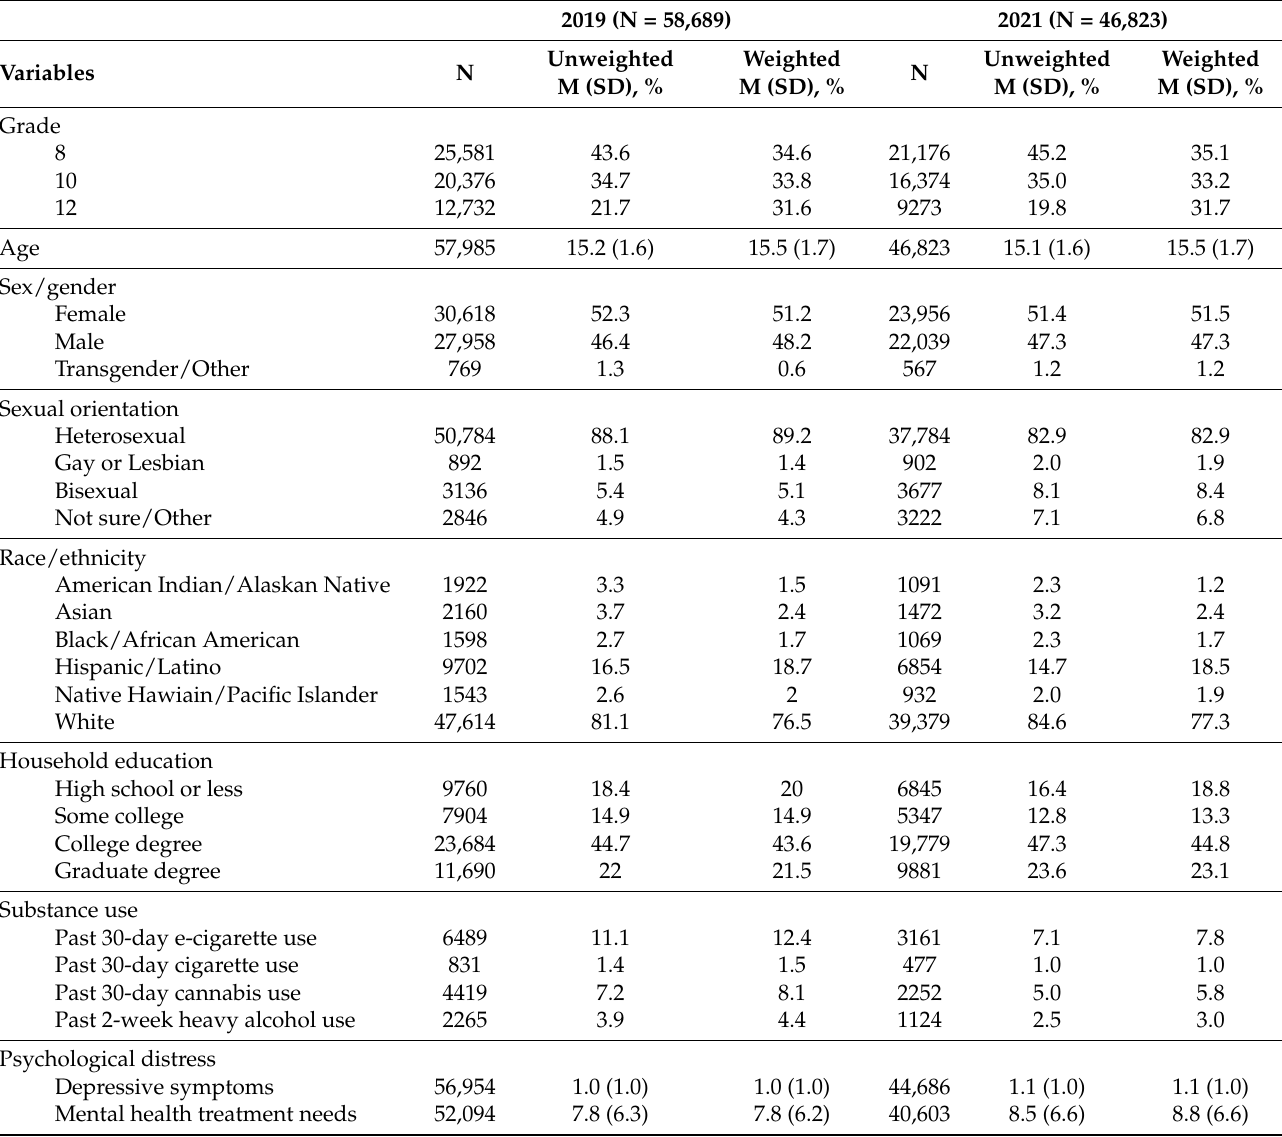
Table 1. Sample characteristics and population